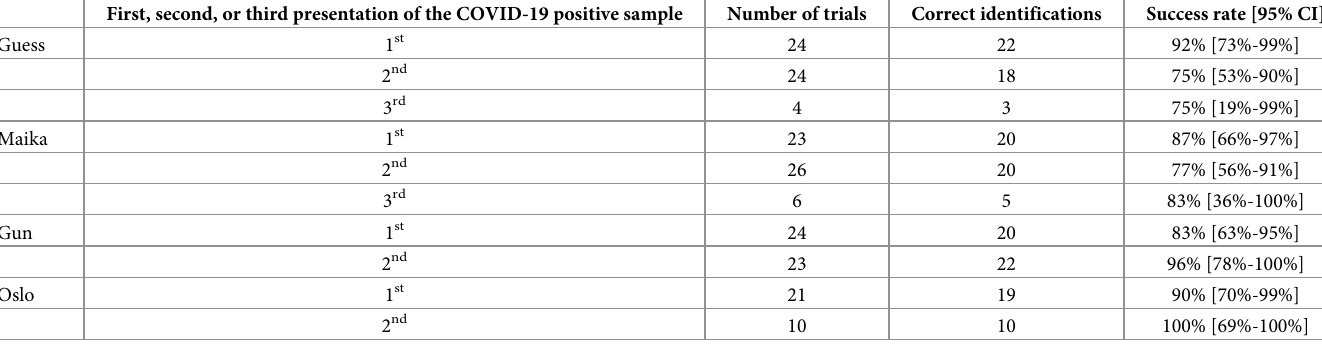
Table 3. Results obtained from the Paris site dogs according to first, second, or third presentation of the COVID-19 positive samples. First, second, or third presentation of the COVID-19 positive